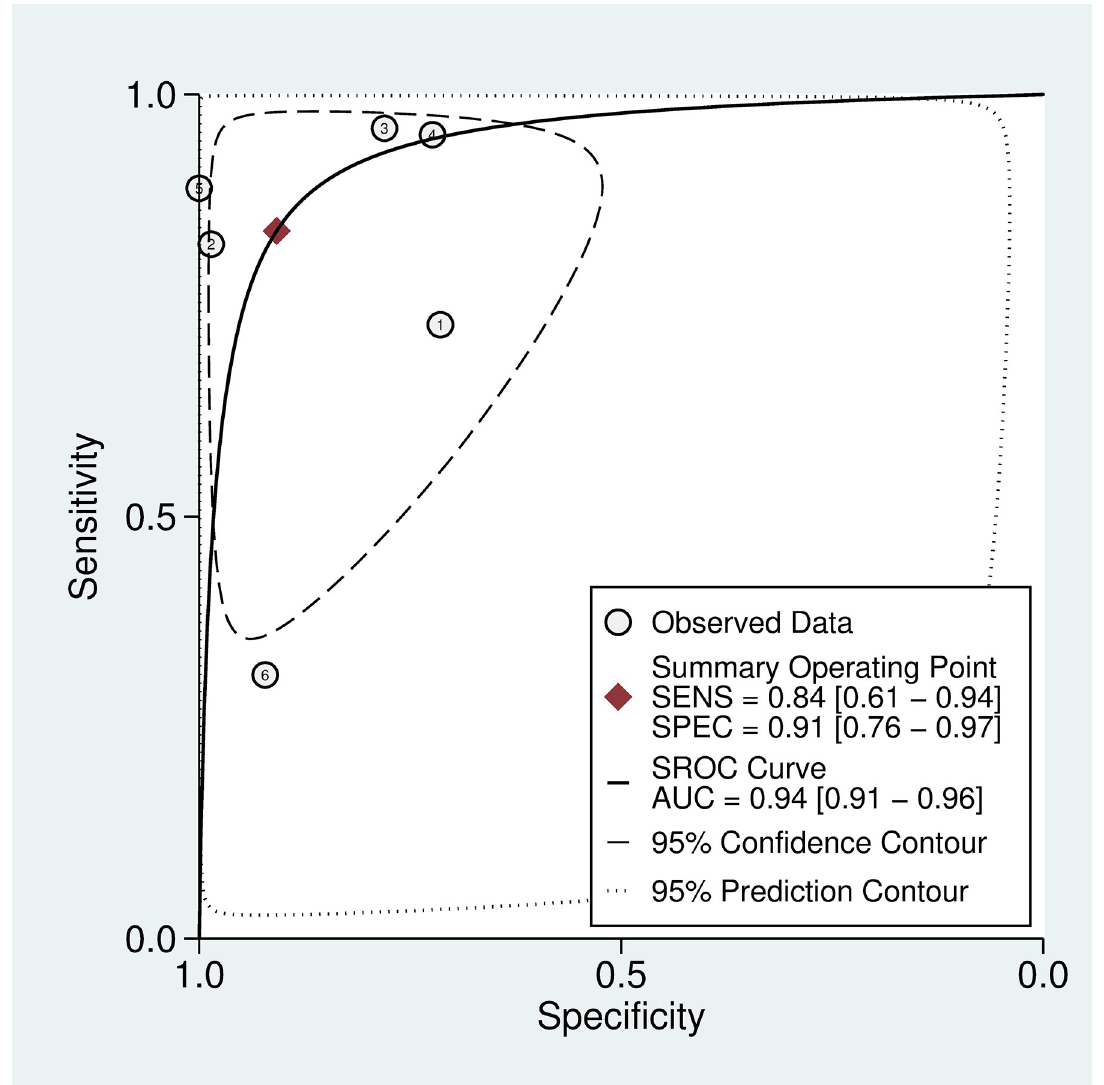
Fig 5. SROC curve for 20WBCT at detecting coagulopathy. SROC curves for 20WBCT at detecting mild coagulopathy defined as fibrinogen < 100 mg/dL.